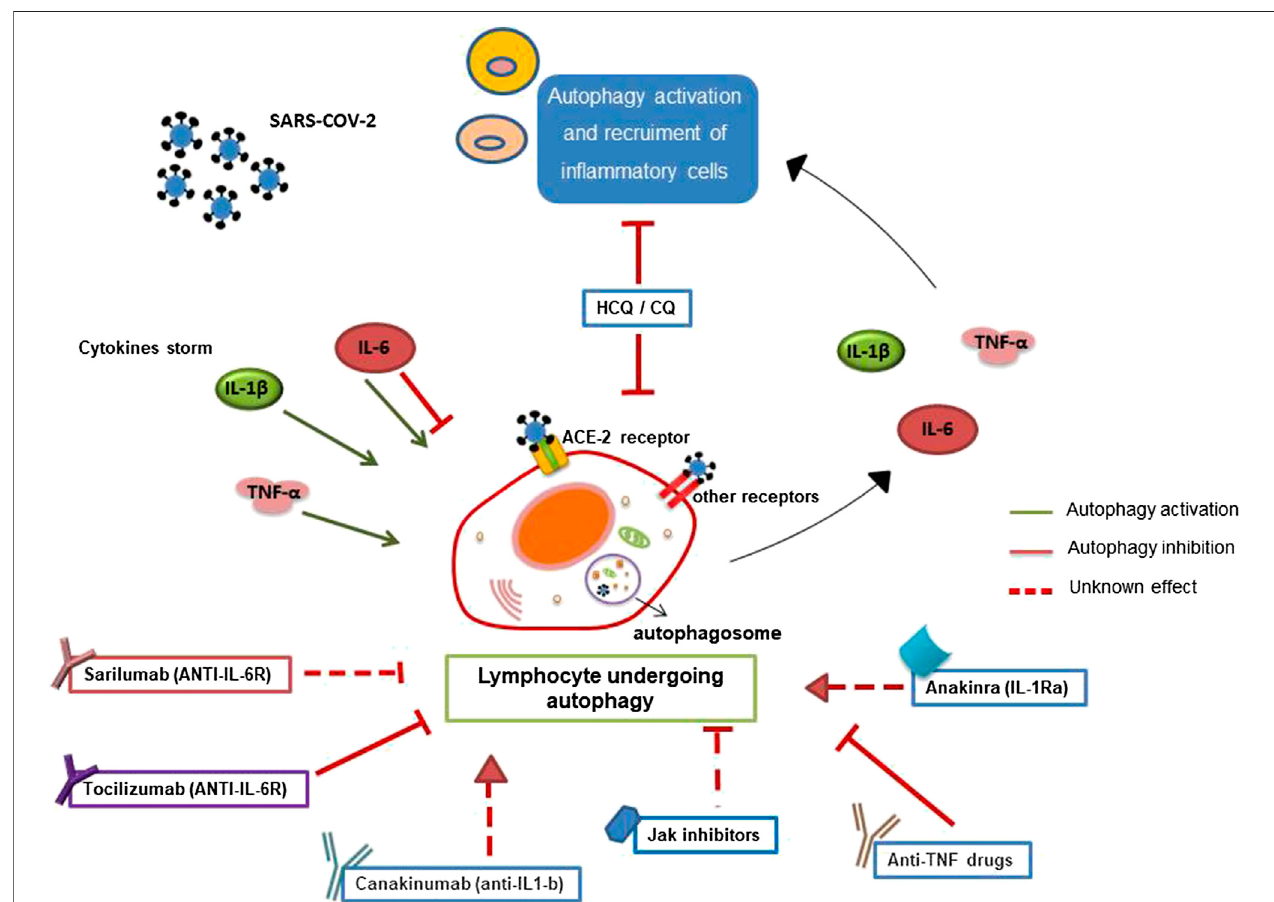
FIGURE 1 | Involvement of autophagy in lymphocyte-mediated in fl ammation during SARS-CoV-2 infection. Autophagy has a crucial role in the survival, activation, and lymphocyte function. Pro-in fl ammatory cytokines, secreted during SARS-CoV-2 infection, could in fl uence autophagy contributing to cytokine storm and in fl ammation. Furthermore, SARS-CoV-2 binding the ACE-2 lymphocyte receptor or the other putative receptors (such as CD147) could play a role in the modulation of autophagy. Several anti-rheumatic drugs, now proposed for the treatment of COVID-19, could target autophagy.